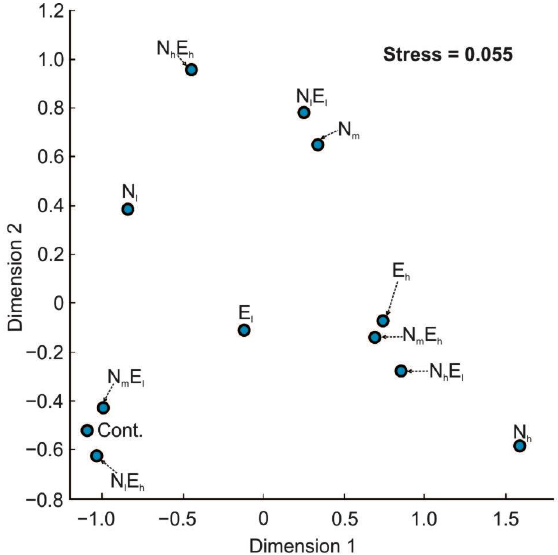
Figure 8. The graphical results of the Bray–Curtis-based NMDS analysis of sequence data, binned by taxonomic assignment to family. The figure shows the relative distances between the gut microbiota of D. magna from the control (Cont.) variant, and from variants of the combination of two variables: (1) NPs in low, medium, and high concentrations (N l , N m , N h , respectively) and (2) enrofloxacin in low and high concentrations (E l and E h ,